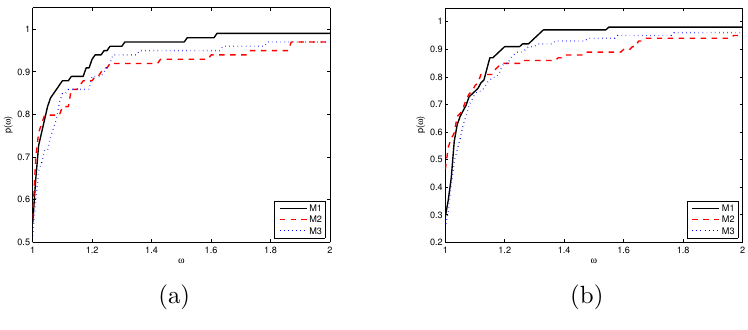
Figure 2. (a) Total number of function and gradient evaluations and (b) the CPU time performance profiles for M1, M2 and